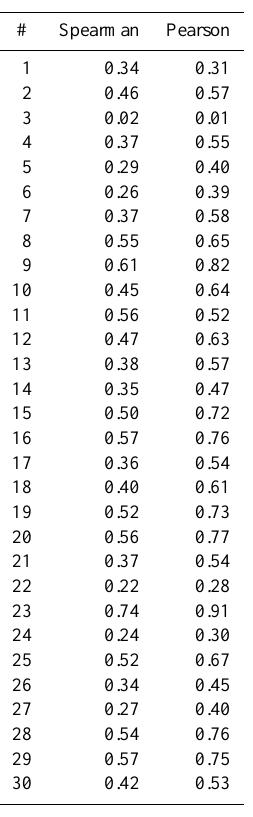
Table 3. Spearman and Pearson correlations between normalised observed groundwater data and calculated